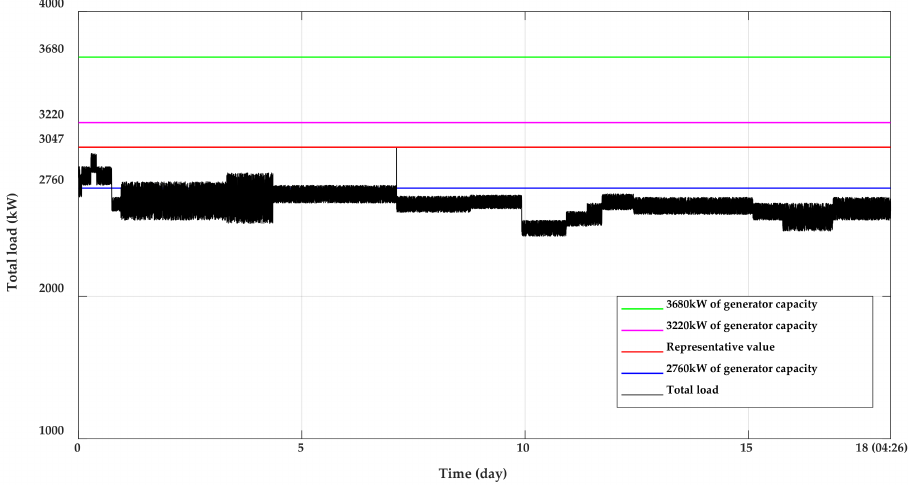
Figure 8. Each generator’s capacity.